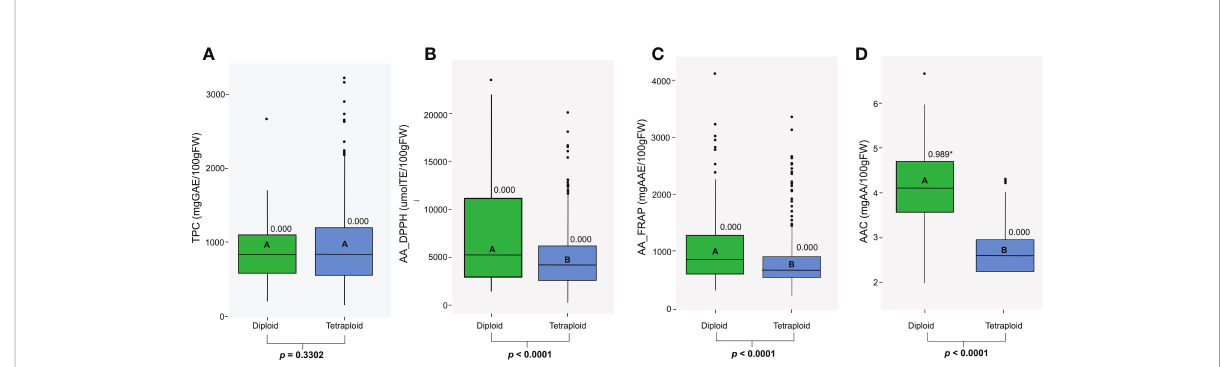
FIGURE 1 Distribution of (A) Total Phenol Content (TPC), (B) Antioxidant Activity measured by a DPPH assay (AA_DPPH), (C) Antioxidant Activity measured by a FRAP assay (AA_FRAP), and (D) Ascorbic Acid Content (AAC) in diploid and tetraploid potato populations. The P-value for the Shapiro-Wilk normality test is shown, and signi fi cant values ( p >0.05) are speci fi ed with an asterisk. The letters and p-values in bold boxplots indicate a signi fi cant difference between populations based on the ANOVA and the Tukey test ( p